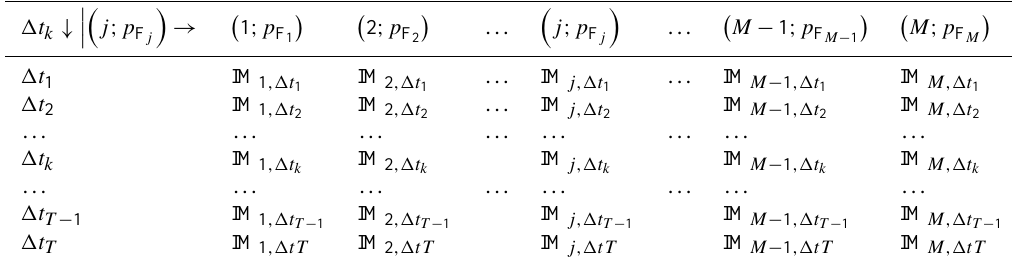
Table 6. Matrix of successions of intensity maps IM j,1t